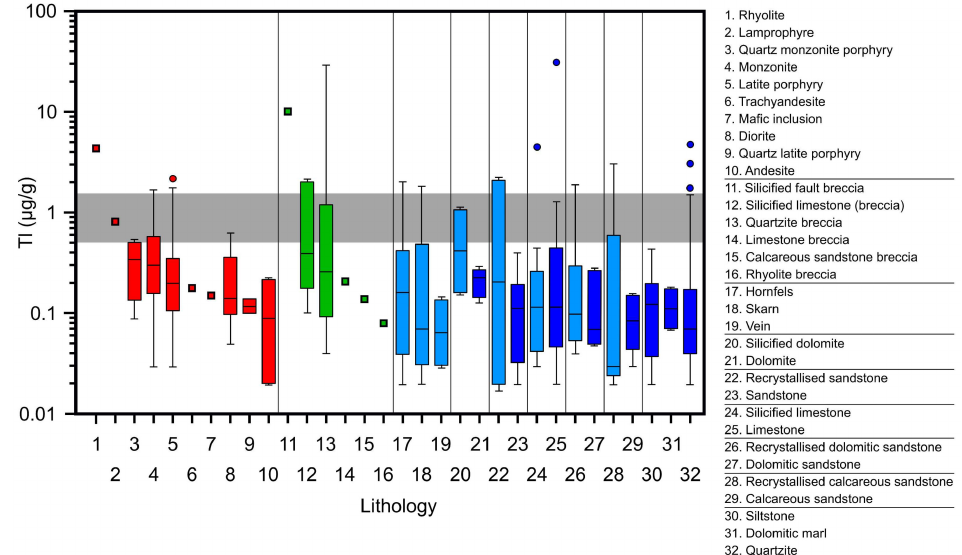
Figure 6. A box and whisker plot showing Tl abundance by lithology in all samples (n = 350) from the Bingham district, with samples grouped into broad lithological categories. “Boxes” denote the first and third quartile values, while the intermediate lines indicate median Tl contents; whiskers extend to the highest and lowest values, excluding outliers (circles), which are >1.5 times the inter-quartile range higher and lower than the third quartile and first quartile measurements, respectively; the solid squares indicate one measurement for a given lithology; colors as in Figures 4 and 5; pale blue color indicates recrystallized/silicified sedimentary lithologies. Note log-scale on y -axis; shaded box indicates range of estimates for Tl content of bulk continental crust [61].